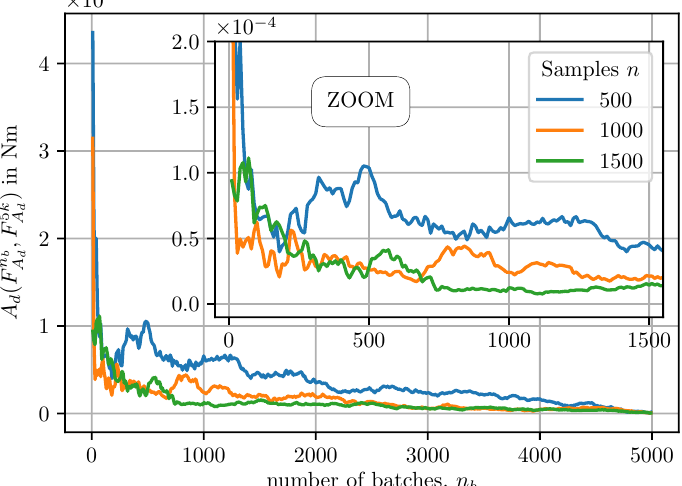
) over number of batches n b for different to F 5 k , A d ( F n b , F 5 k A d A d A d A d